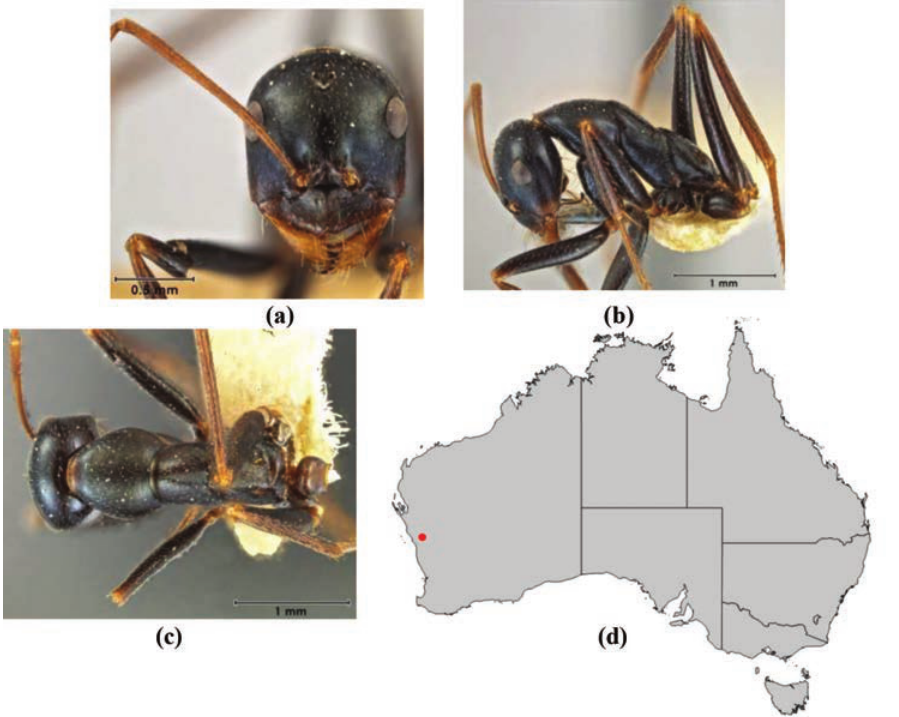
Figure 16. Melophorus mullewaensis sp. n.: minor worker holotype (ANIC32-06621–top ant) frons ( a ), profile ( b ) and dorsum ( c ); distribution map for the species ( d